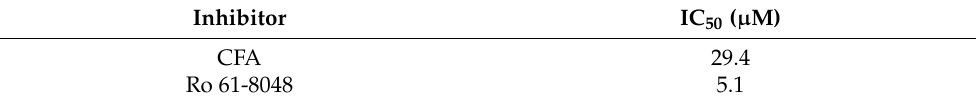
Figure 3. Inhibitory effects of C. sativa compounds on KMO. ( A ) Percent inhibition of C. sativa compounds on KMO enzyme activity at 100 µ M. ( B ) Percent inhibition of KMO by CFA at 2.5–40 µ M. ( C ) Percent inhibition of KMO by Ro 61-8048 at 2–10 µ M. Table 2. The inhibitory effects IC 50 values of CFA and Ro 61-8048 against the KMO enzyme.